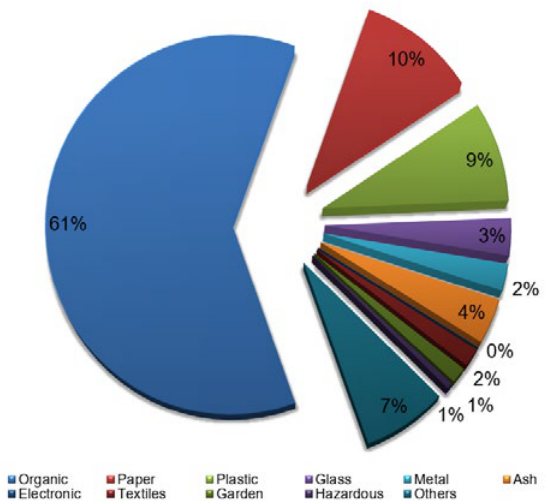
Fig. 2: Artvin general solid waste characterization in percent